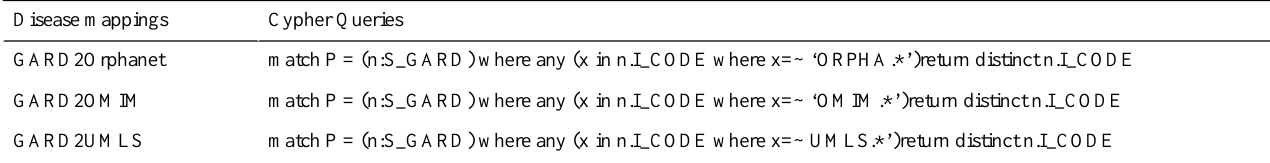
Table 1. Disease mapping extraction from the Neo4j knowledge graph.